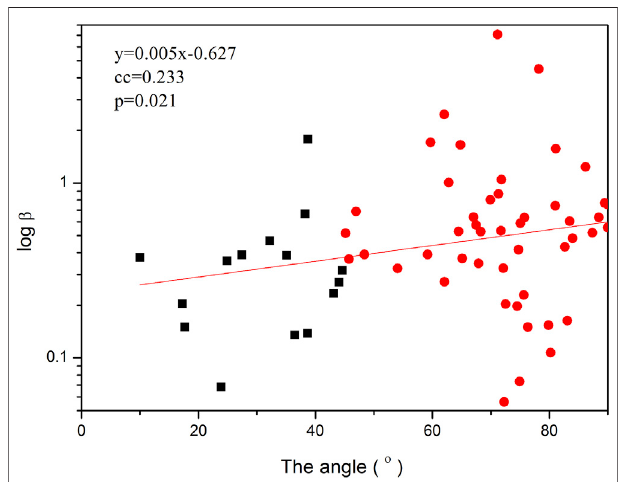
FIGURE 6 | The distribution of plasma β with the angle between the axis of the rope and the normal of the associated HCS. The red dots represent the SIMFRs of CAT1 category. The black squares represent SIMFRs of CAT2 category.The correlation coef fi cient (cc) and p value ( p ) are shown in the upper left corner.